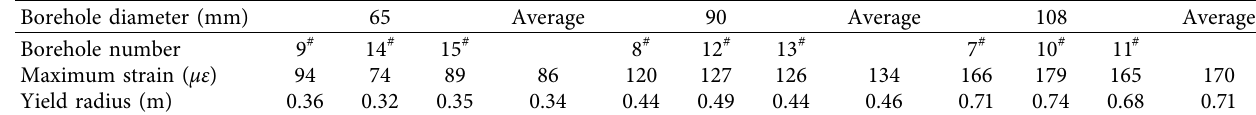
Table 2: Statistics of maximum strain and yielded zone radius for different borehole